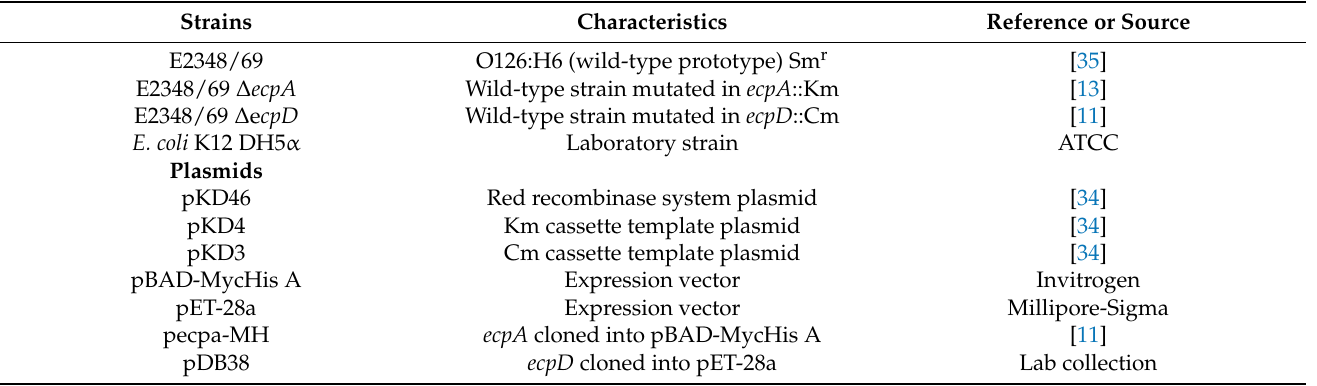
Table 1. List of the strains and plasmids